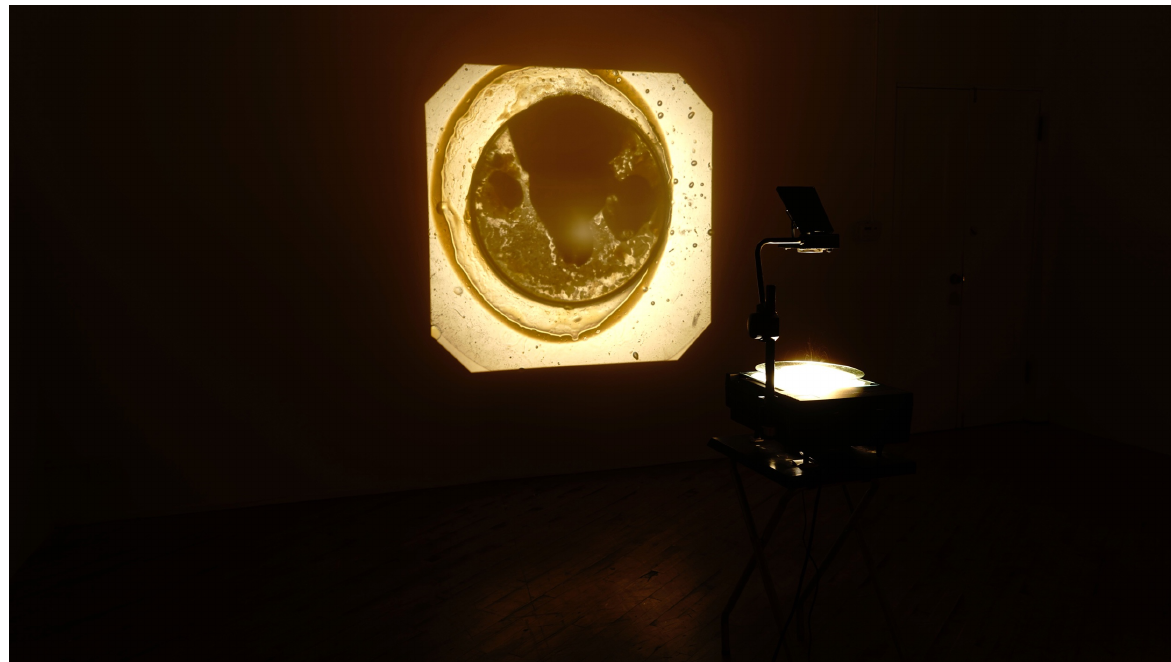
Figure 6: Studio installation view of Crude Illumination (2015) for ISEA2016 Hong Kong Artist Talk. Photo: Elia